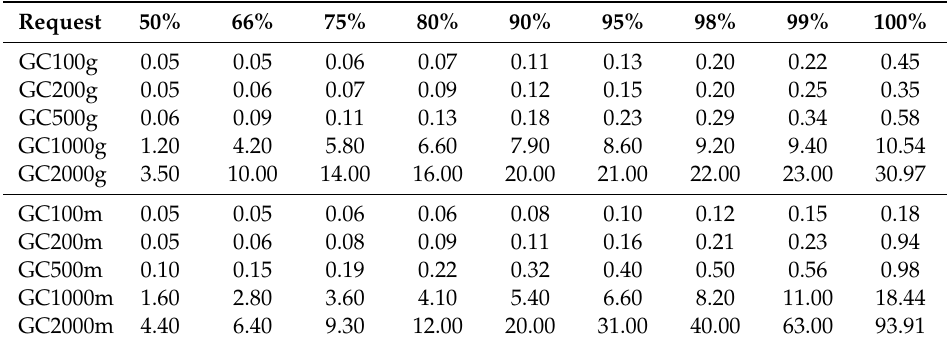
Table 8. Percentage of getCapabilities requests completed within given times (in seconds) for the di ff erent configuration of concurrent users and WSGI server (case A).